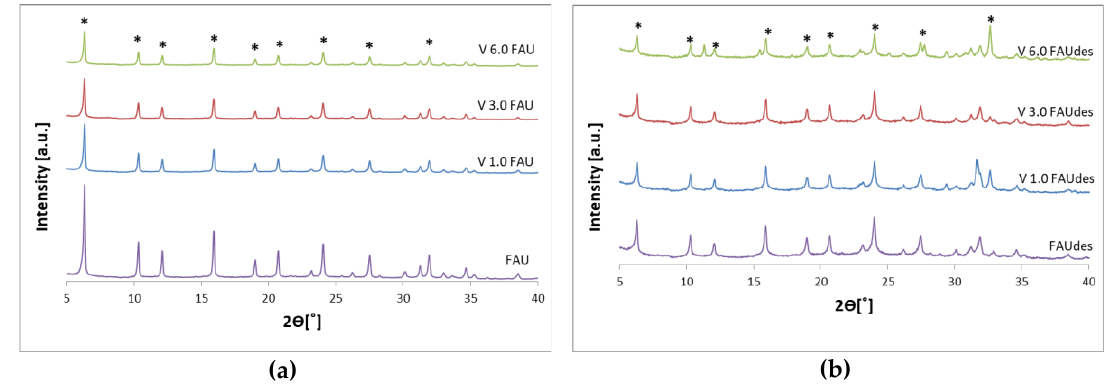
Figure 1. X-ray diffraction (XRD) diagrams of the obtained V x FAU ( a ) and V x desilicated FAU (FAUdes) ( b ) samples. Peaks corresponding to the faujasite (FAU) crystal phase are marked with asterisks (*).